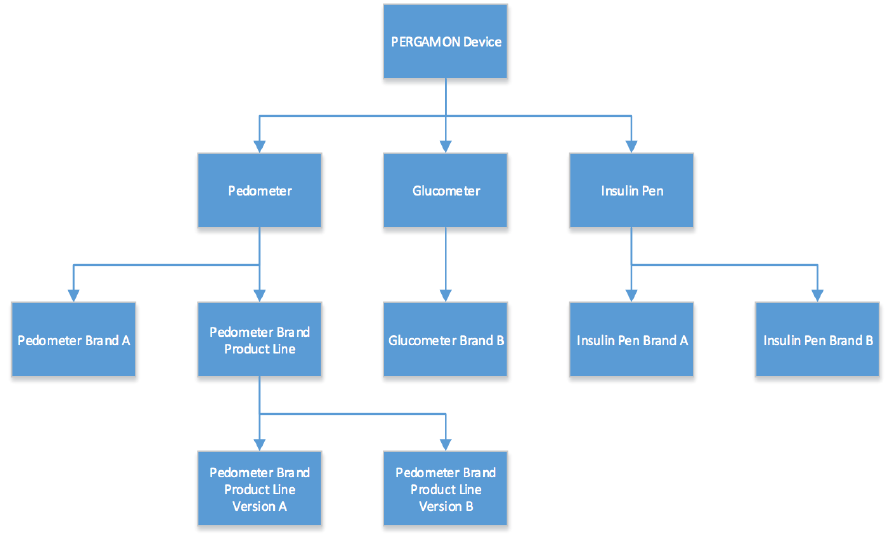
Figure 3. The architecture of the Sensor